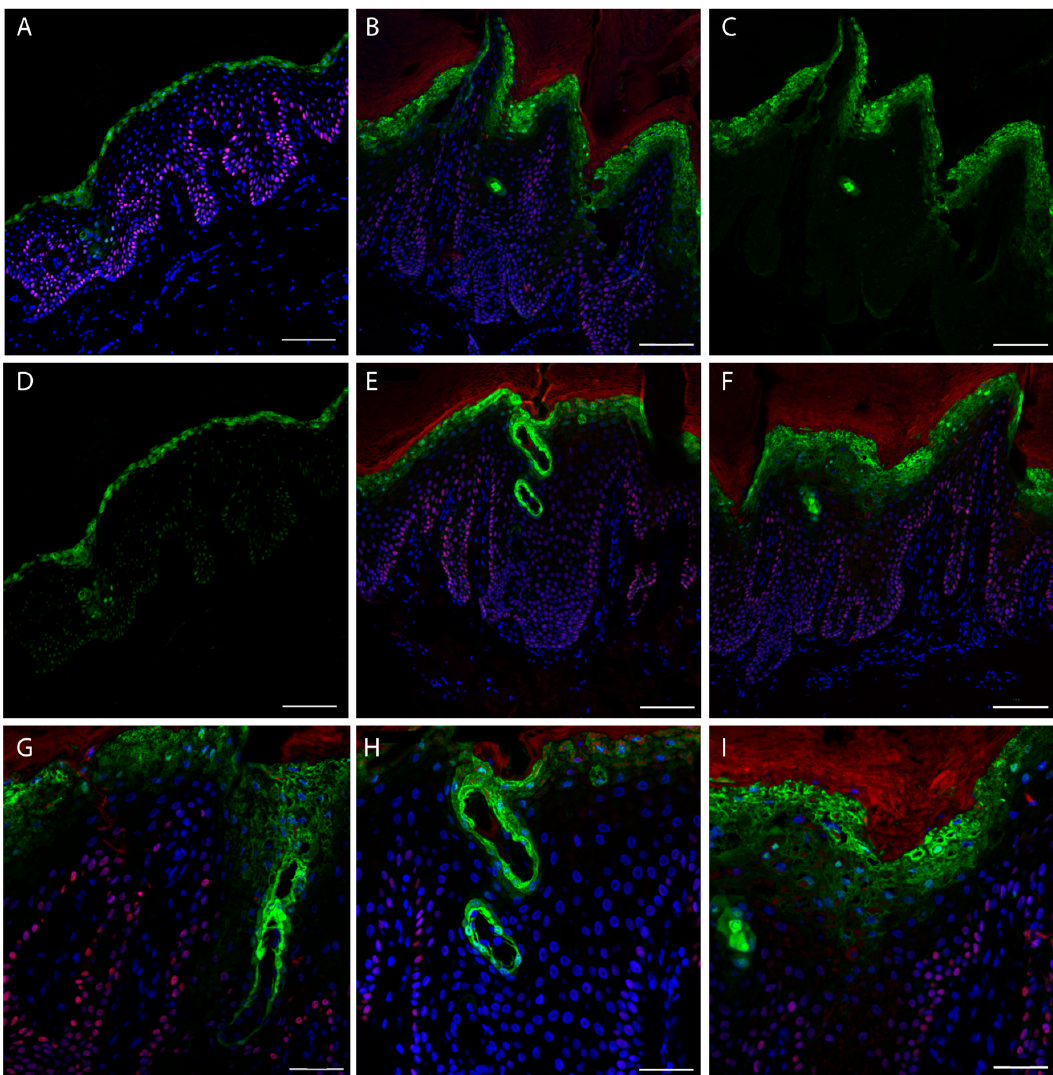
Figure 4. Skin confocal immunofluorescence analysis. Staining for p63 (red) and Loricrin (green). ( A ) Staining with p63 and loricrin merged with DAPI (Blue) of a control section. ( B ) Staining of a patient section. ( C ) Patient section (same of B ) showing only loricrin signal. ( D ) Single channel acquisition of the control section showing only loricrin. ( E , F ) Patient skin stained with loricrin, p63 and DAPI. ( A – F) Scale bar = 100 μ m, 20× objective. ( G – I ), staining of patient sections with loricrin, p63 and DAPI at higher magnification; scale bar = 50 μ m, 40× objective. The p63 staining is not completely exhaustive about its localization and also shows interference by the corneum layer. We performed a further confocal analysis using Alexa fluor ® 488 (green) for p63 and Alexa fluor ® 568 (red) secondary antibody for K1 staining, this used a higher energy laser and a smaller pinhole. Moreover, a high magnification (60× objective) was used to better characterize the ultrastructural changes in the suprabasal epidermal layer of the patient. This epidermis, as previously evidenced, shows an in ‐ creased thickness of the suprabasal, with a high number of nuclei positives to p63 staining (Figure 5A–C), not restricted to the basal layer. As it is appreciable in enlarged captures (Figure 5D–E, and Figure S1), p63 is expressed only in the nucleus of keratinocytes; in the K1 staining (Figure 5D,E, stars, and Figure S1), keratin clumping is visible. Moreover, soft ‐ ware image analysis detected a higher number of p63 positive nuclei in the patient section (Figure S2).